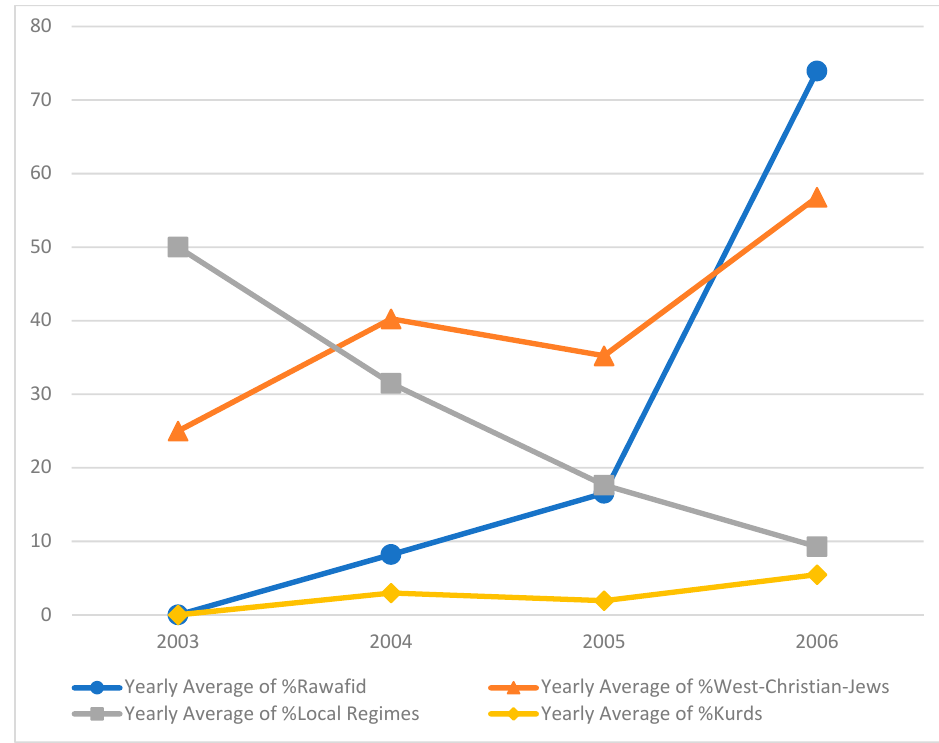
Figure 4. Development of out-groups in Zarqawi’s statements in yearly average percentage of oc- currences.